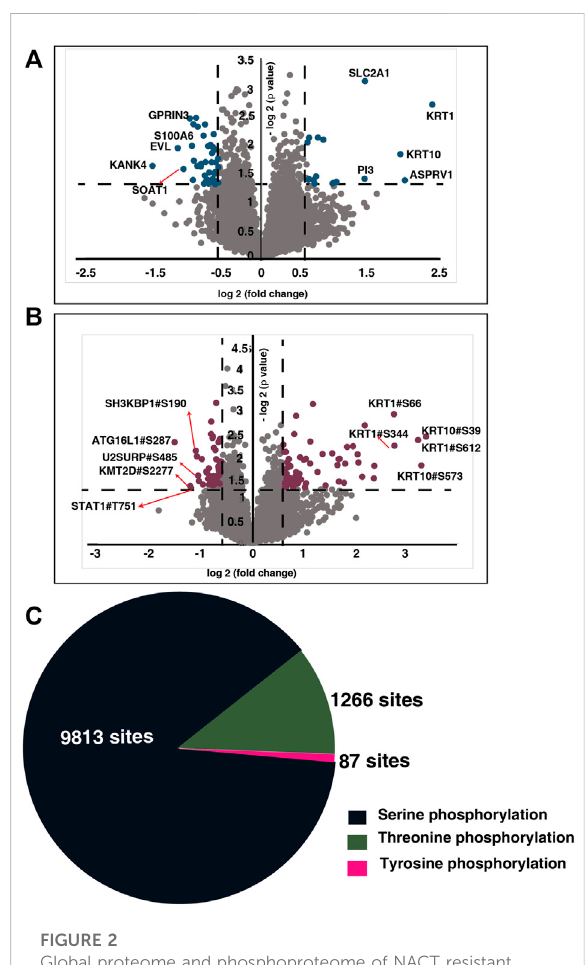
FIGURE 2 Global proteome and phosphoproteome of NACT resistant and sensitive TSCC patients. (A) Volcano plot of global proteome of NACT resistant and sensitive tongue cancer patients. Fold change of the protein abundances (log2) are plotted against the t -test p -values (-log10). Dashed lines represent signi fi cant levels. Data points in blue color are signi fi cantly dysregulated proteins (fold change cut off > 1; p -value < 0.05). (B) Volcano plot of phosphoproteome of NACT resistant and sensitive tongue cancer patients. Fold change of the protein abundances (log2) are plotted against the t -test p -values (-log10). Dashed lines represent signi fi cant levels. Data points in maroon color are signi fi cantly phosphorylatedproteins(foldchangecutoff > 1; p -value < 0.05). (C) Pie chart representing the number of serine, threonine and tyrosine phosphosites identi fi ed in our